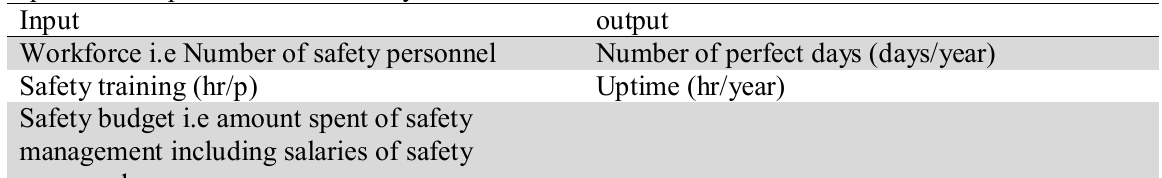
Inputs and output variable for safety evaluation